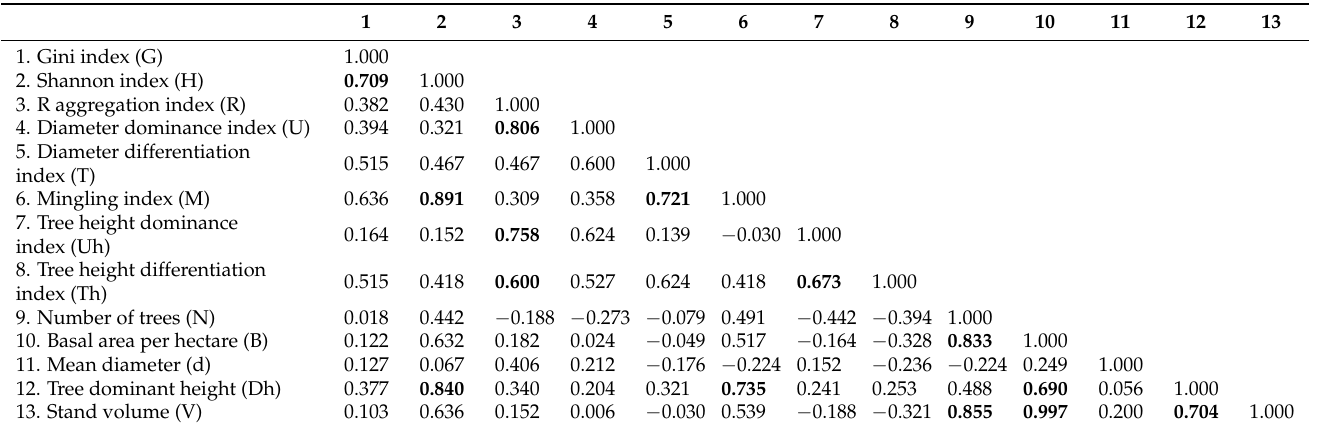
Table 1. Correlation coefficients (Spearman’s r ) between stand structural indices and stand structural parameters in the European beech forest. Associations that were statistically significant ( p < 0.05) are in bold.